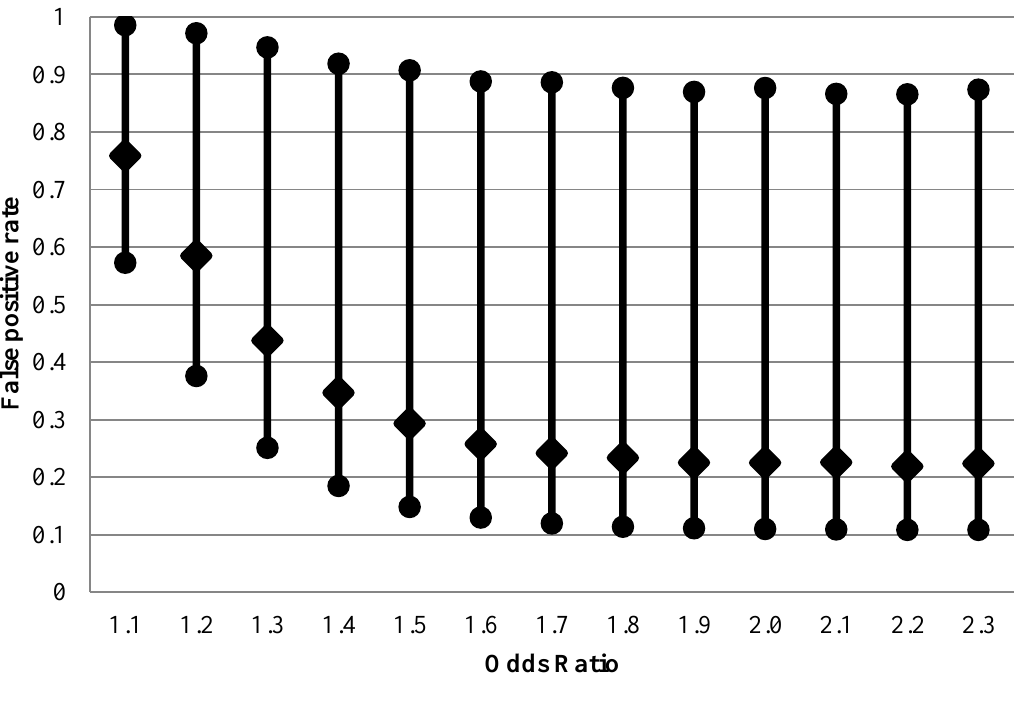
Figure 2. False positive rate (2.5th, 50th and 97.5th percentiles of 20,000 Monte-Carlo simulations) when exposure is imperfectly classified (sensitivity 0.5 and specificity 0.9) for fixed distribution of belief about probability of the effect being null (1500 case-control sets, type I error 5%, prevalence of exposure 30%, true rather than apparent odds ratios are